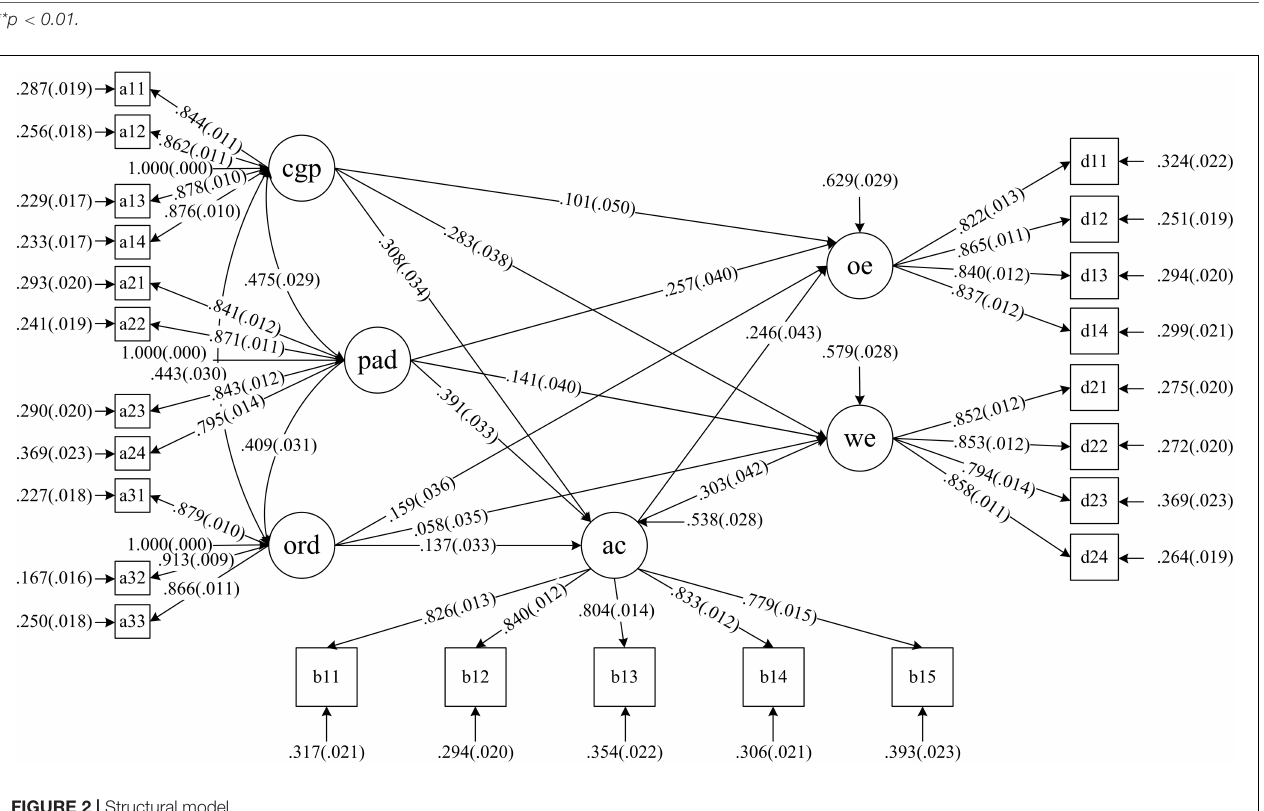
FIGURE 2 | Structural